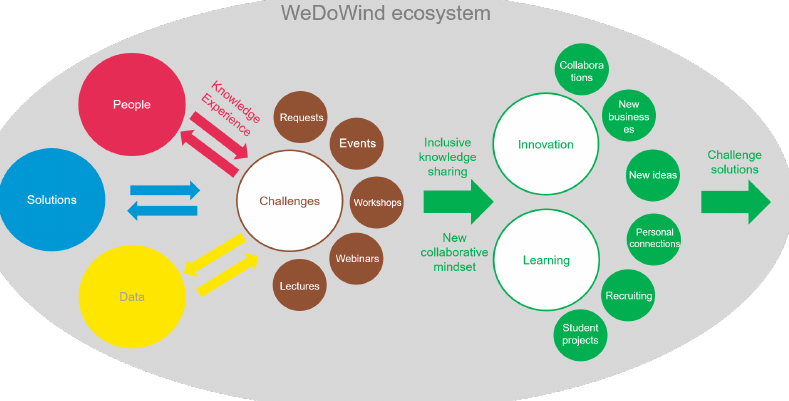
Figure 1. Schematic representation of the new collaboration method applied in this work, the digital